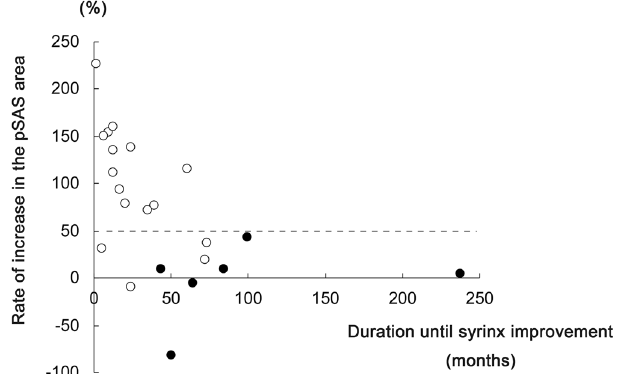
Figure 3. Scatter plot showing the time to syrinx resolution. The vertical axis is the rate of increase in the pSAS area after FMD. The horizontal axis is the duration until syrinx improvement. Points over 250% on the vertical axis were not presented. White and black circles indicate syrinx improvement and no improvement, respectively. The dashed line indicates a 50% rate of increase in the pSAS